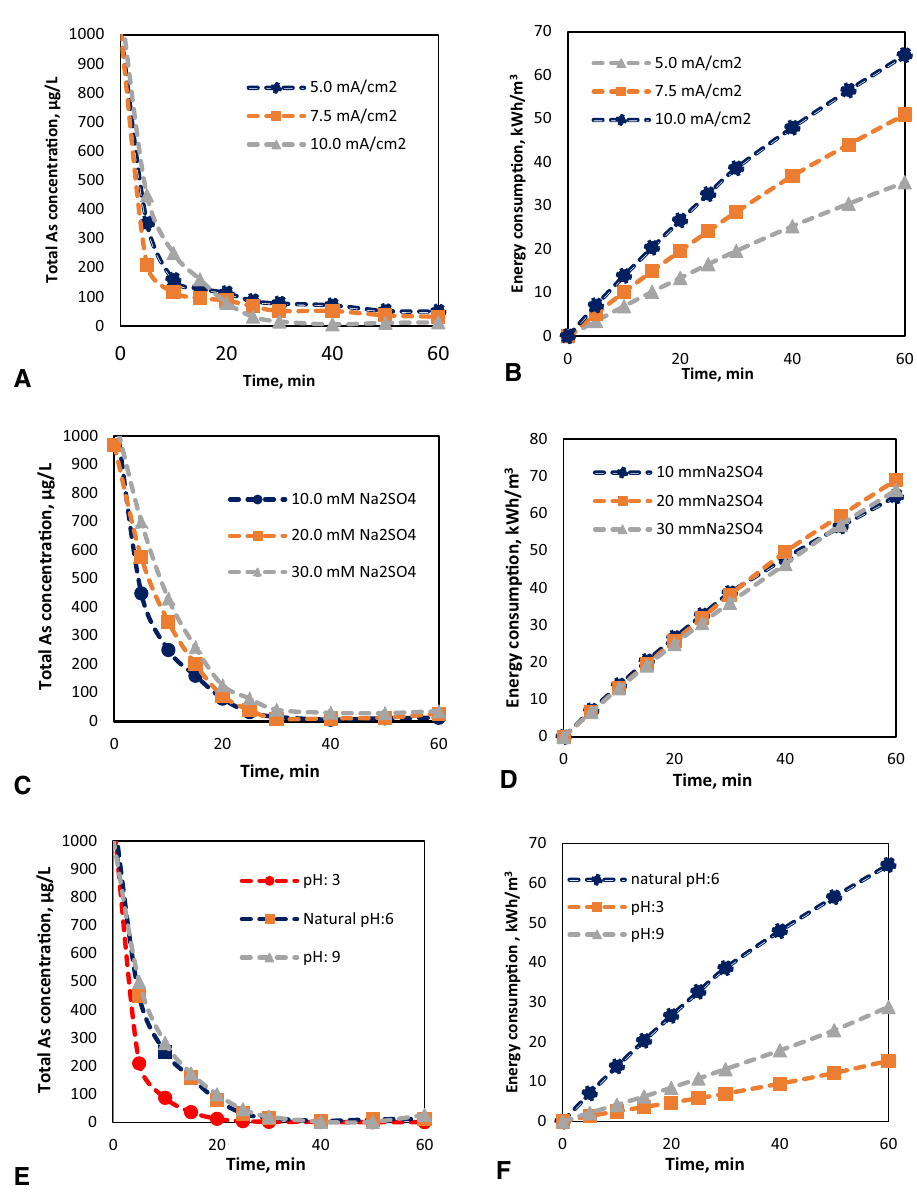
Electrocoagulation